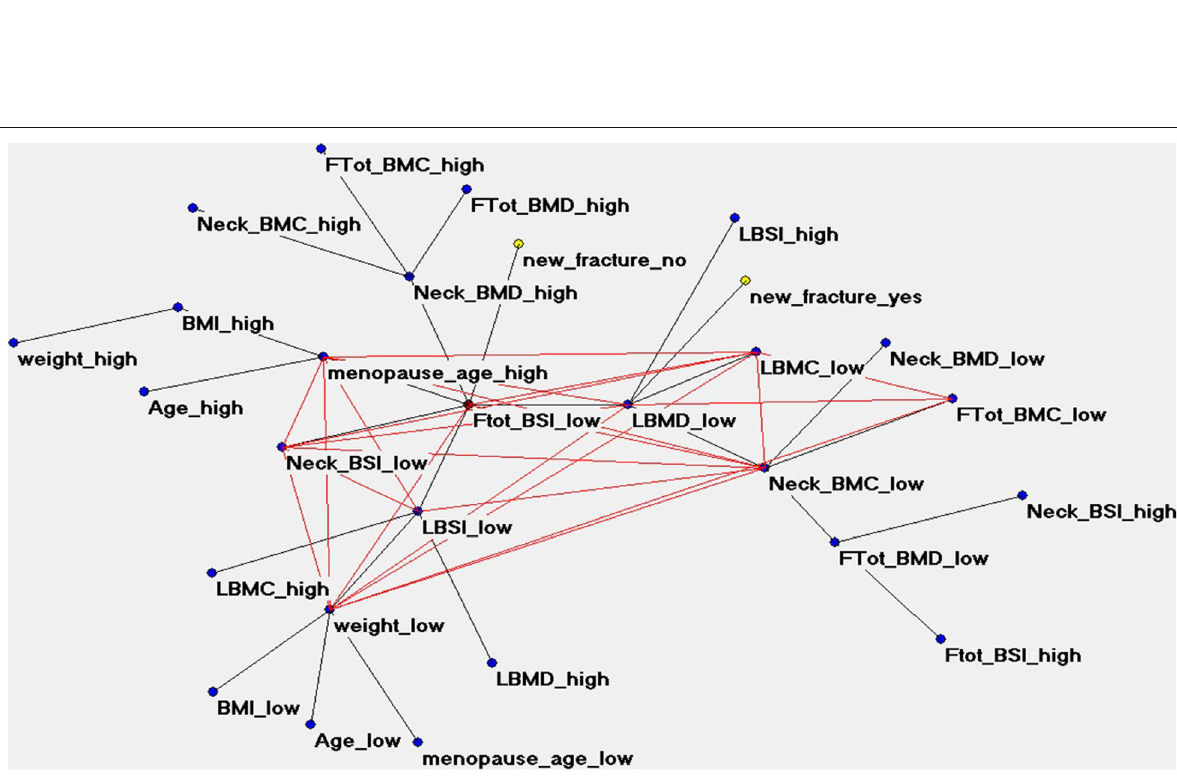
Fig. 6 ANN semantic connectivity map with maximally regular graph, a sort of diamond showing the multiple interconnections among variables, suggesting the inherent complexity of the data structure. Ftot, Total femur; BMC, Bone mineral content; BMD, Bone mineral density; BSI, Bone strain index; LBMC, Lumbar BMC; LBMD, Lumbar BMD; LBSI, Lmbar BSI. “ High ” refers to high values, “ low ” refers to low